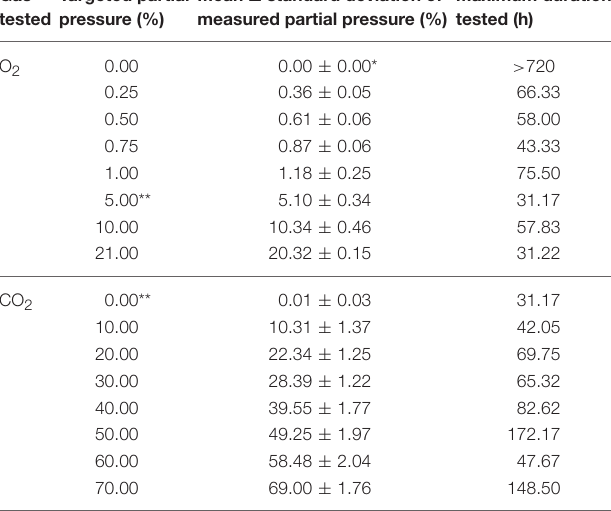
TABLE 1 | Mean values ± standard deviation of dioxygen (O 2 ) or carbon dioxyde (CO 2 ) partial pressures (%) measured in three replicates of modified-atmosphere culture devices containing PDA plates inoculated with Paecilomyces